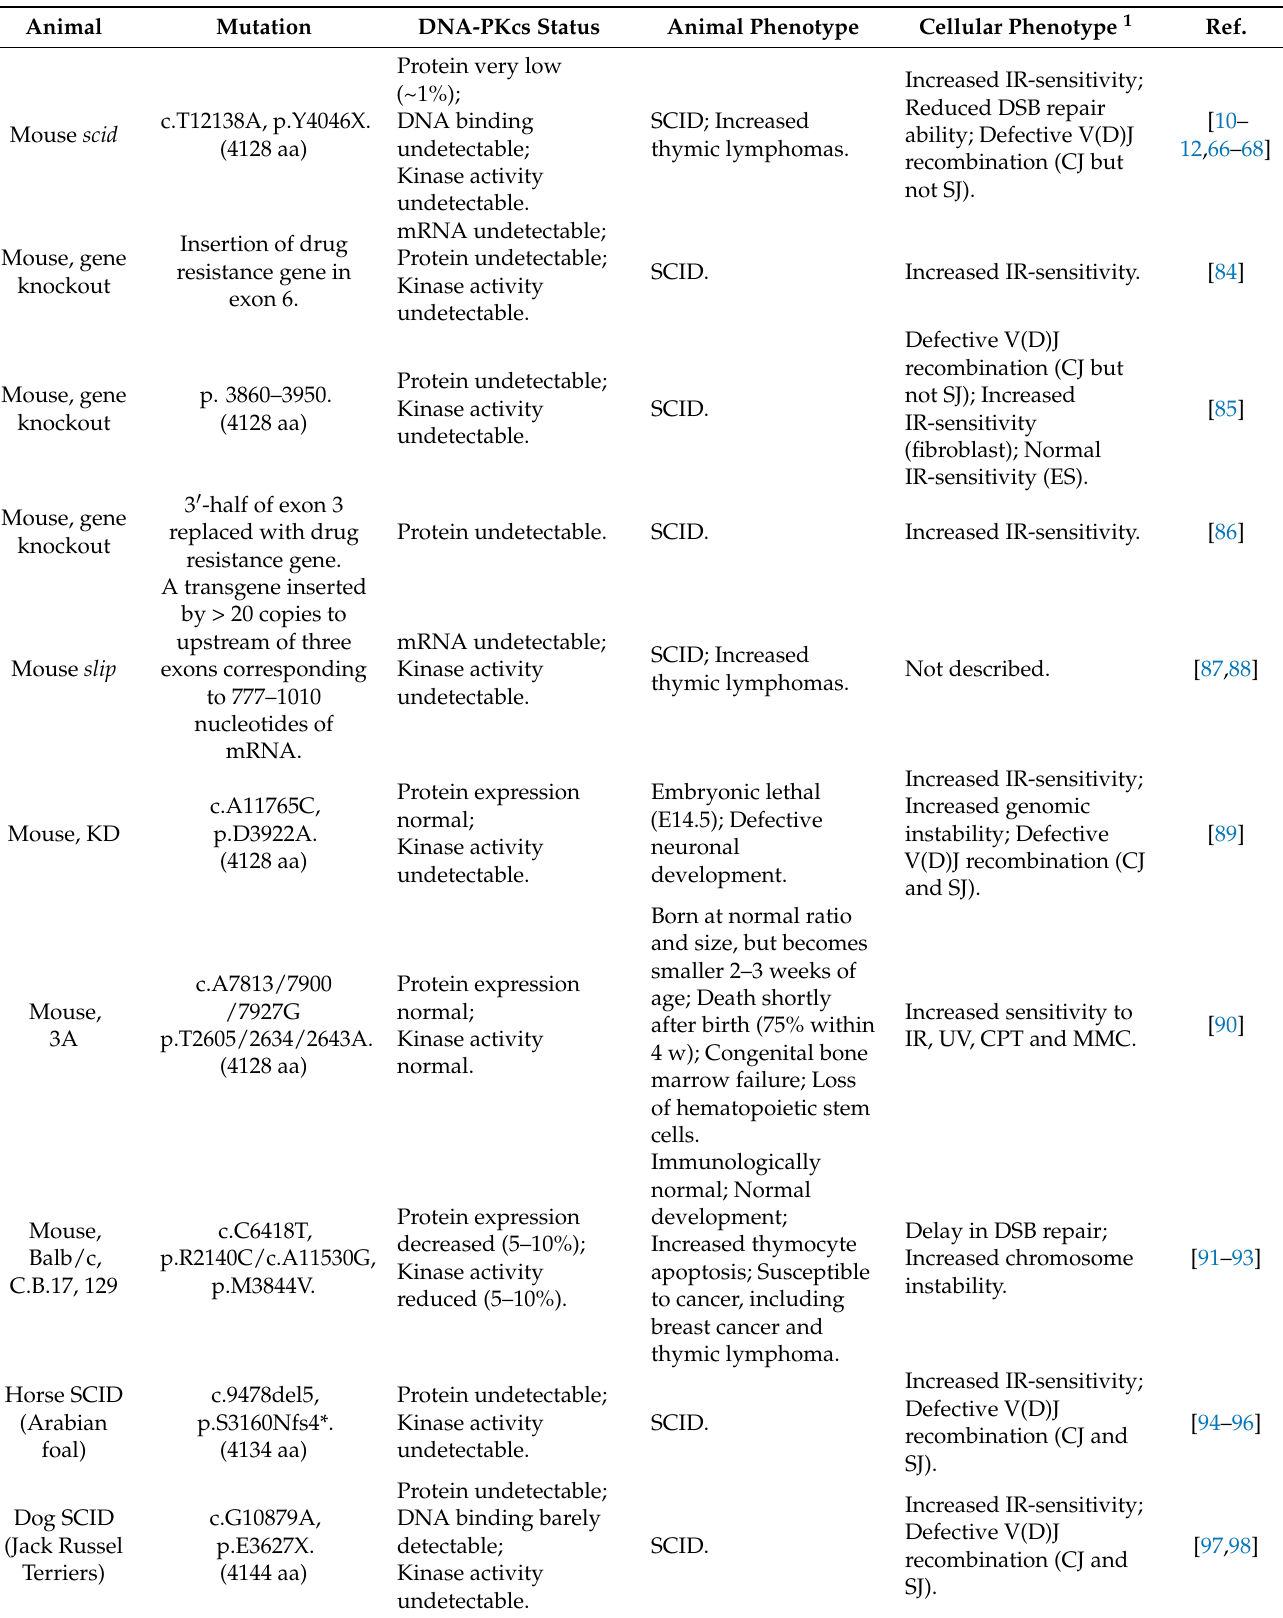
Table 3. DNA-PKcs-deficient